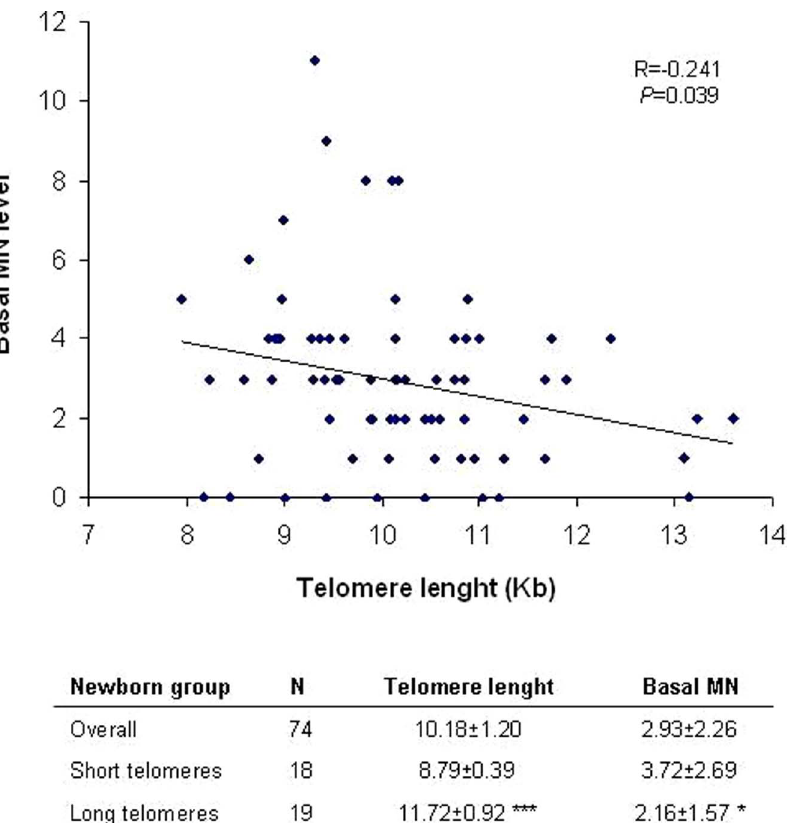
Figure 2. Correlation between TRF length and newborn baseline genetic damage. A negative significant association is observed, were individuals with shorter telomeres present significantly higher levels of DNA damage. The mean 6 SEM values of telomere length and basal DNA damage are also indicated for the overall population (N=74) and for the individuals with shorter (N=18) and longer (N=19) telomeres. Individuals with shorter telomeres show significant higher level of DNA damage. Student t -test for long vs short telomere groups; * P , 0.05, ** P , 0.01.